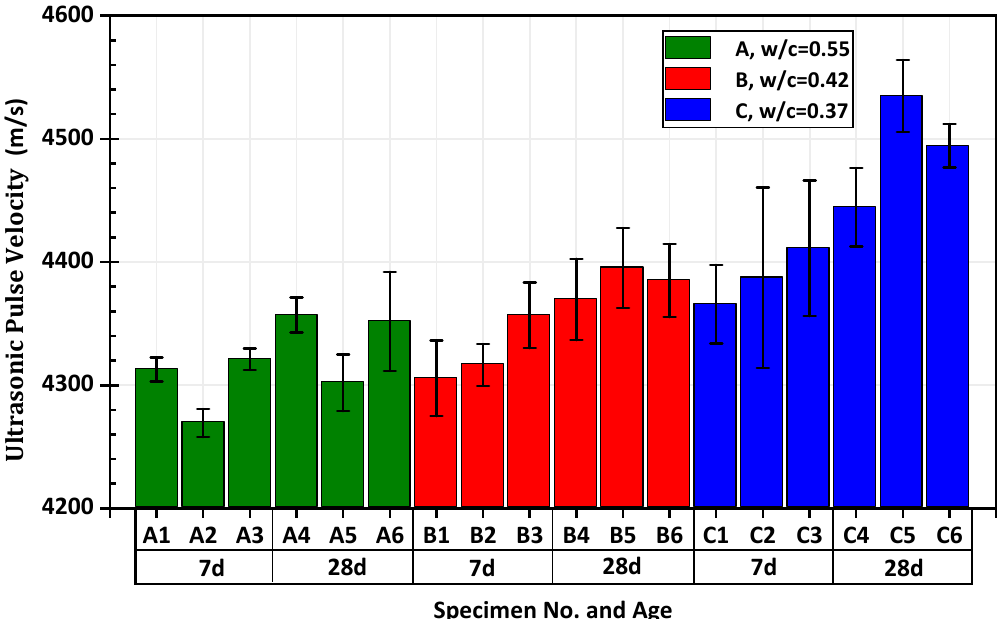
Figure 12. The result of ultrasonic testing with standard error.